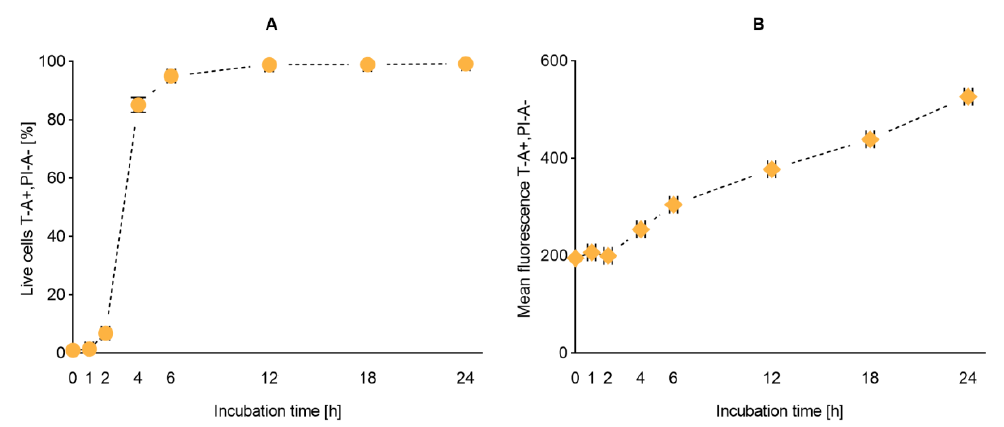
Figure 6. Uptake of T1 liposomes by RAW 264.7 macrophages. Liposomal uptake was expressed as percentage of fluoresce-activated live cells (panel A ) and mean fluorescence (panel B ). Each point represents mean ± SD on the y-axis ( n = 3). A standard error of ± 5 min was given as default on the incubation time for the practical handling of the samples. Abbreviations: T refers to the lipid dye; T-A + , PI-A- represent the gate for fluorescence-activated live cells; SD is standard deviation.